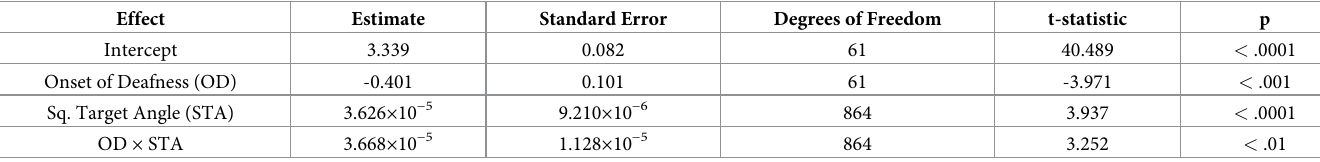
Table 2. Fixed-effects coefficients from mixed-effects